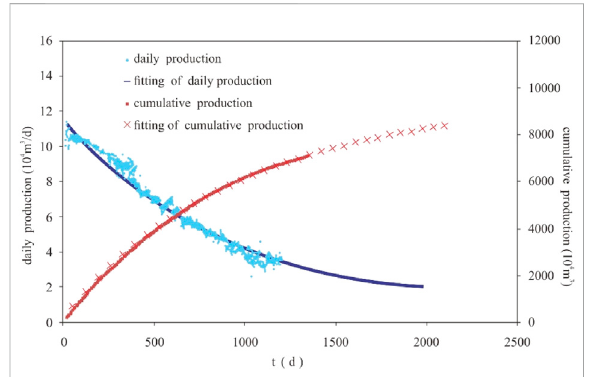
FIGURE 12 Historical fi tting curves of the production and cumulative production of horizontal wells with class I reservoir quality.